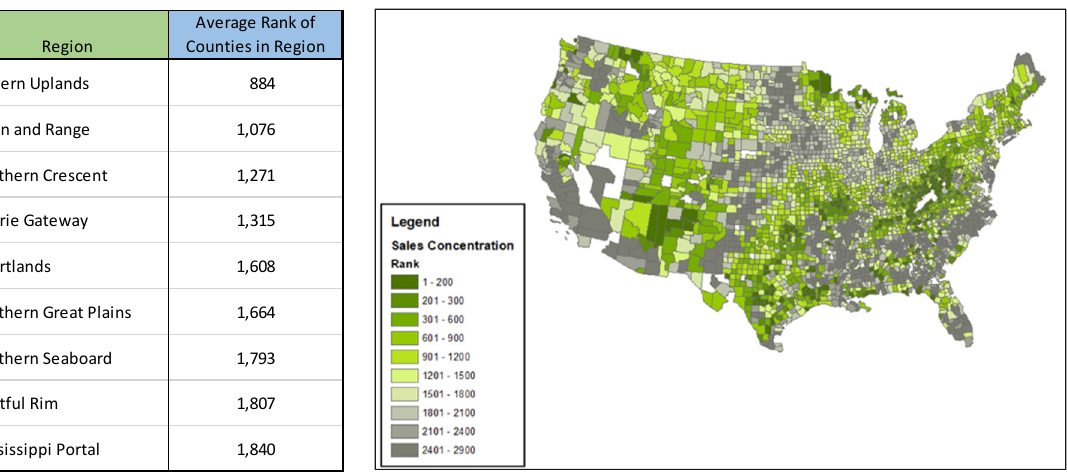
Table 14. Region Ranking: Sales Concentration, 2012 Map 13. Sales Concentration Rank,